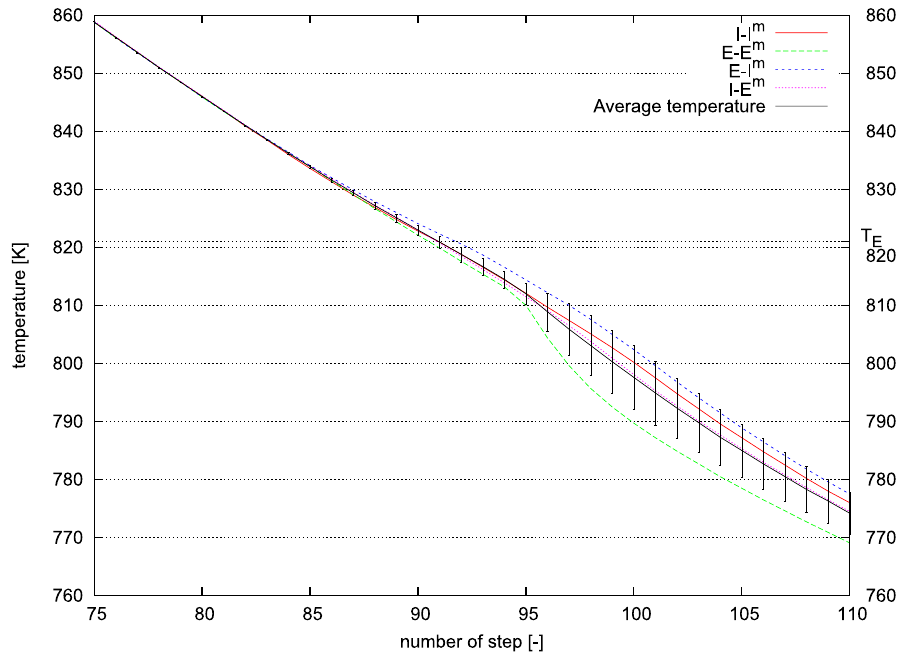
Figure 12. Standard deviation. Average temperature and standard deviation for multiplication factor m = 1.